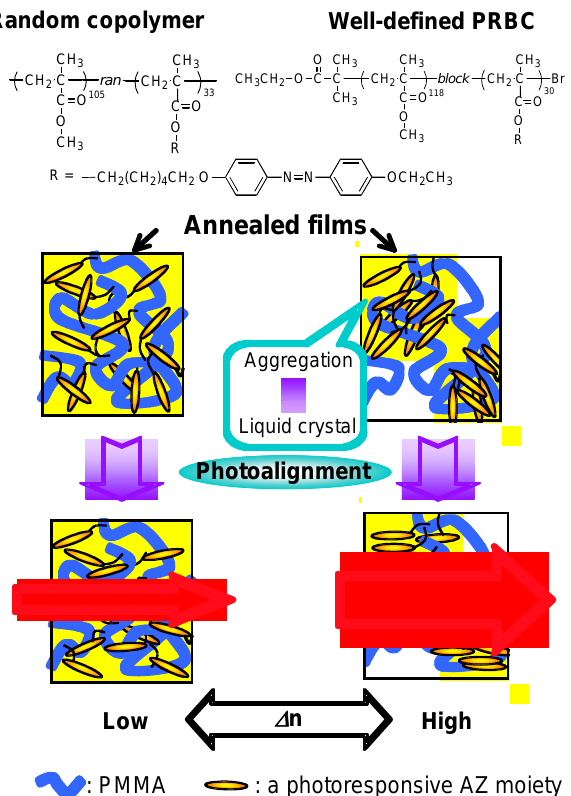
Figure 11. Schematic illustration of a well-defined PRBC and a random copolymer with a similar chromophore content (about 22 mol %).